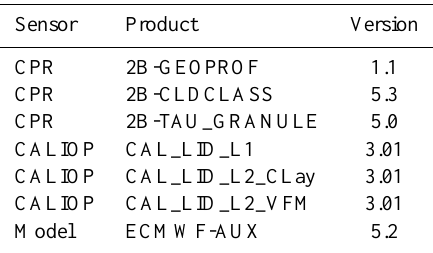
Table 5. List of CPR and CALIOP products used for the validation of the SEVIRI